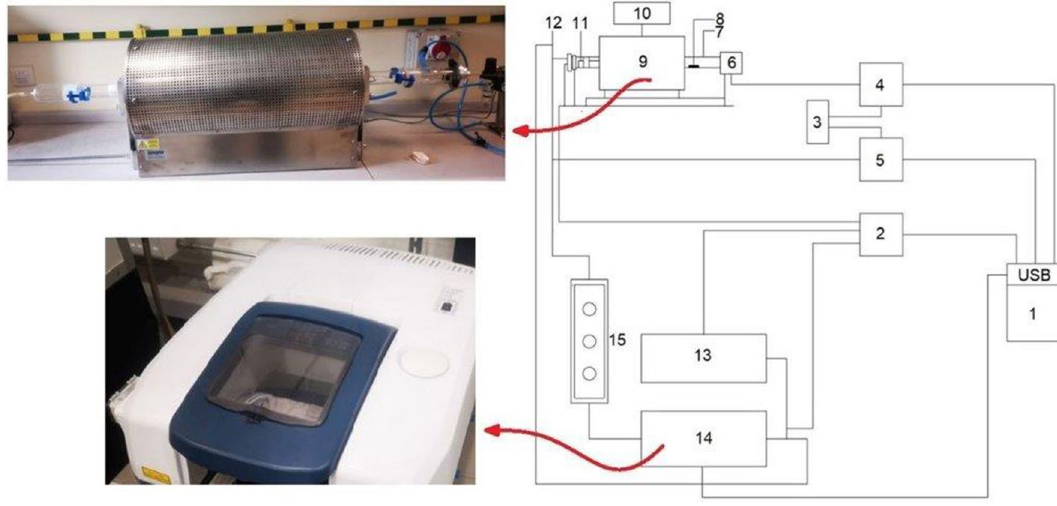
Figure 2. Stand for testing the toxicity of products of the combustion of materials used in the production of belts; 1—furnace, 2—FTIR gas analyser in Laboratory of Combustion and Explosion Processes of Józef Tuliszkowski Fire Protection Scientific and Research Center in